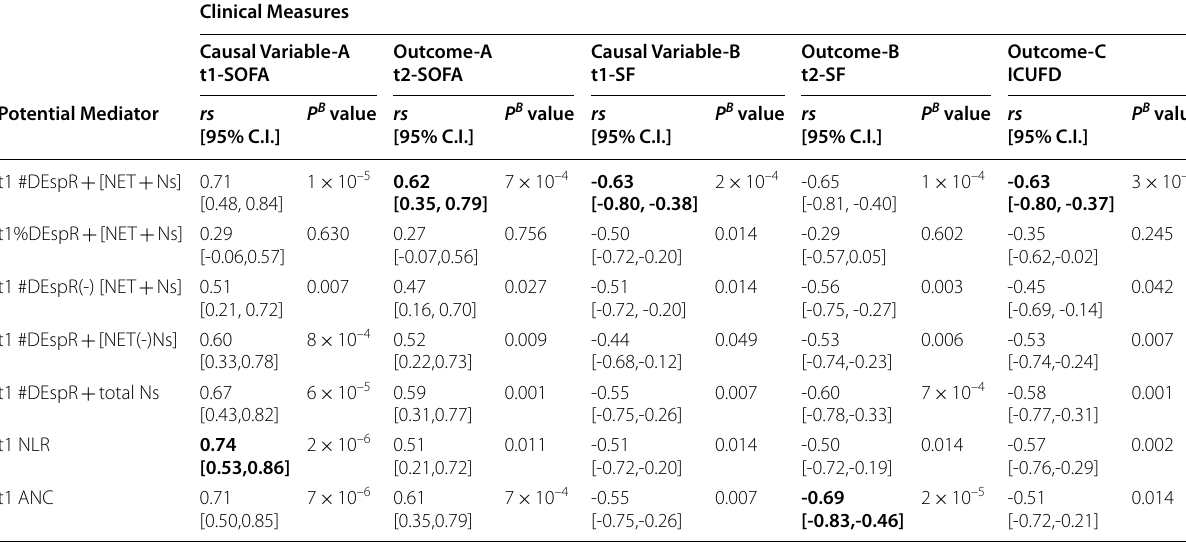
Table 2 Spearman rank correlation coefficients ( rs ) of peripheral neutrophil‑based markers with clinical measures of severity in acute COVID‑19 patients ( n =